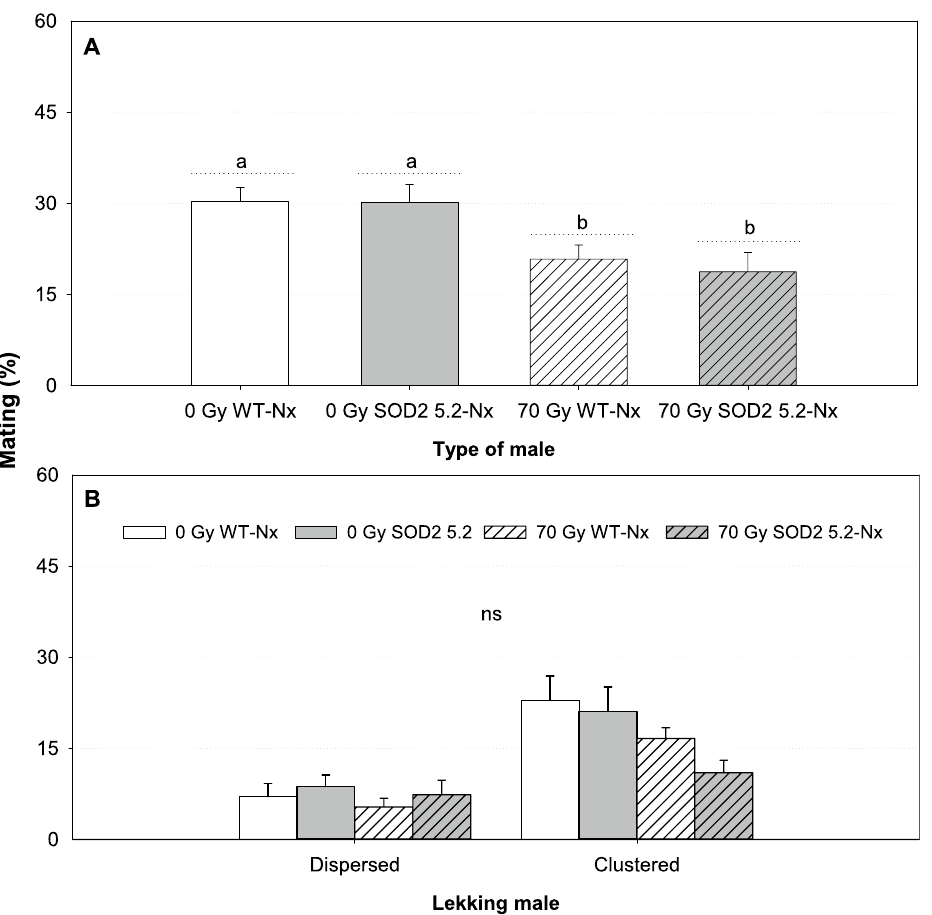
Figure 4. Mean mating success (SE) and position within leks of non-irradiated and normoxia-irradiated Anastrepha suspensa males competing together for the same females in tests with a high male: female ratio (100 males: 25 females). ( A ) Proportion of matings obtained by non-irradiated WT (0 Gy WT-Nx), non-irradiated SOD2 5.2 (0 Gy SOD2 5.2-Nx), irradiated WT (70 Gy WT-Nx), and irradiated SOD2 5.2 (70 Gy SOD2 5.2-Nx) males. ( B ) Distribution of dispersed and clustered males within leks from matings achieved by 0 Gy WT-Nx, 0 Gy SOD2 5.2-Nx, 70 Gy WT-Nx, and 70 Gy SOD2 5.2-Nx individuals. Bars followed by different letters are significantly different from each other (GLMM, LS-means contrasts, P < 0.05). Graph marked with ‘ns’ indicates no statistically significant difference within each group (dispersed or clustered) for our MANOVA model ( P > 0.05). Figures were created using Sigma Plot (SigmaPlot for Windows version 14.0, Copyright 2017, Systat Software, Inc. Palo Alto, CA,